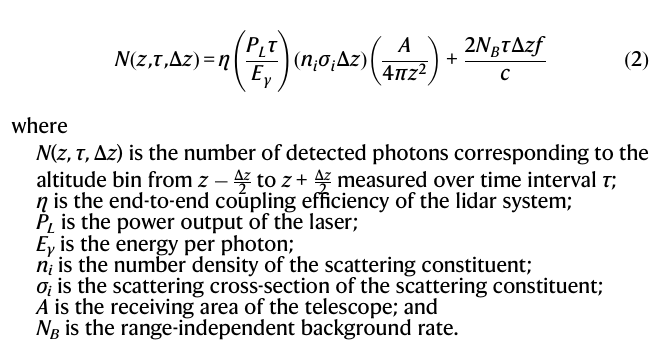
Fig. 6 | Example raw lidar return plots. a Example raw return count pro fi le for a single 10s interval with 2km vertical resolution, showing the Rayleigh return to >50km. The vertical black line shows the background estimate for these data. b Example raw return count pro fi le for morning data with solar zenith angle between 97 and 110° from measurements taken between January 13 and February